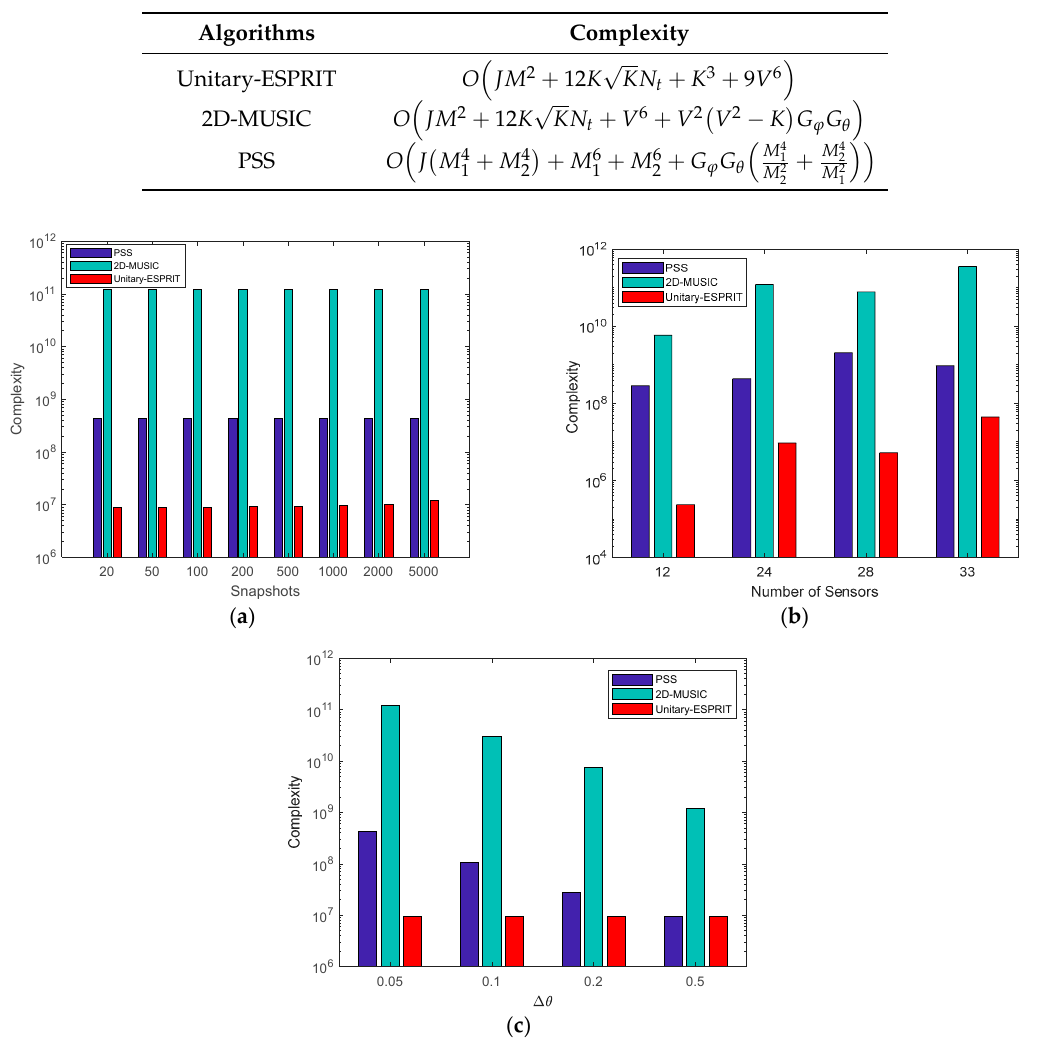
Figure 3. Complexity comparison ( a ) versus snapshots when M 1 = 3, M 2 = 4, ∆ θ = 0.05 ◦ ; ( b ) versus the number of sensors when J = 500, ∆ θ = 0.05 ◦ ; ( c ) versus the searching step when M 1 = 3, M 2 = 4, J =